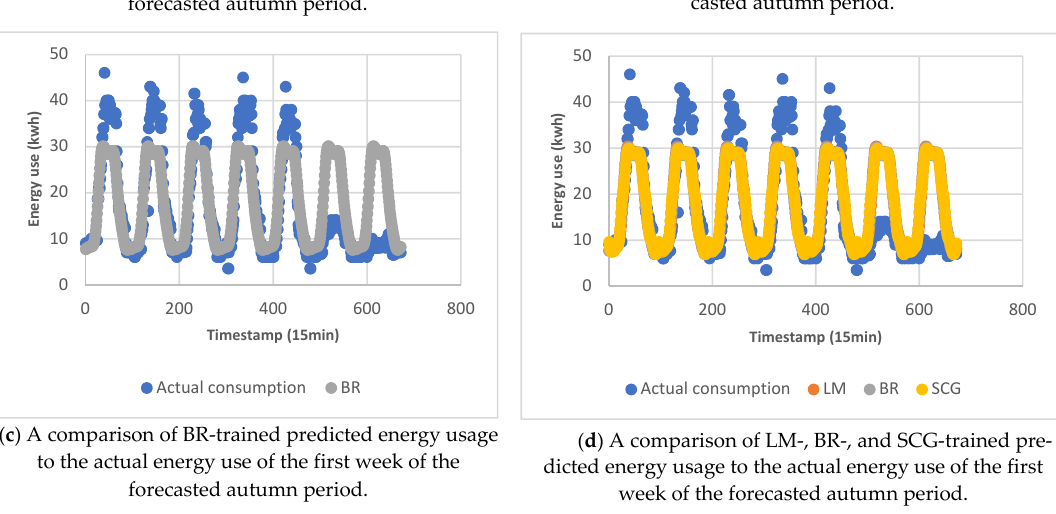
( b ) A comparison of SCG-trained predicted energy us- age to the actual energy use of the first week of the fore- casted autumn period.